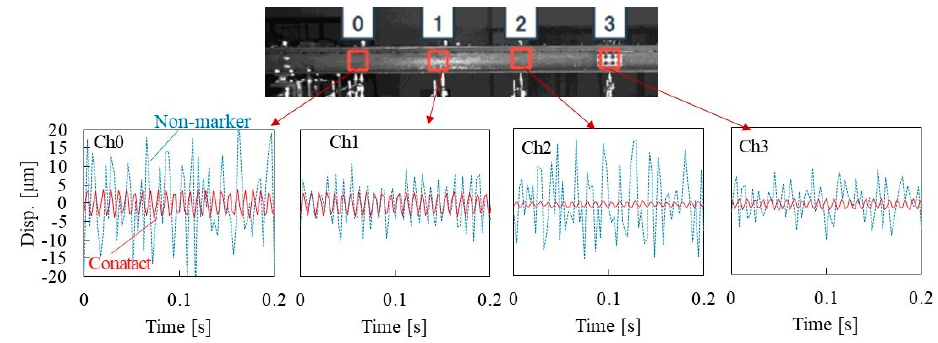
Figure 12. Comparison of displacement responses during 120 Hz excitation at the L/4